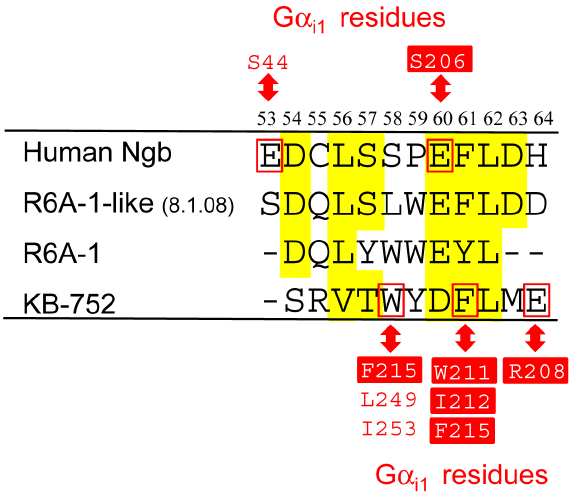
Figure 5. Hydroxyl radical scavenging activities of human WT, E53Q, E60Q, R97Q, E118Q, E151N Ngb, a ROS scavenger, N- acetylcysteine (NAC), and myoglobin (Mb). The reaction was initialized by addition of hydrogen peroxide and was incubated at 37 u C for 60 min. The absorbance of the mixture at 536 nm was measured. Data are presented as the mean 6 SEM of three experiments. Data were analyzed by one-way ANOVA followed by Tukey-Kramer post hoc tests. *P , 0.05, **P , 0.01.